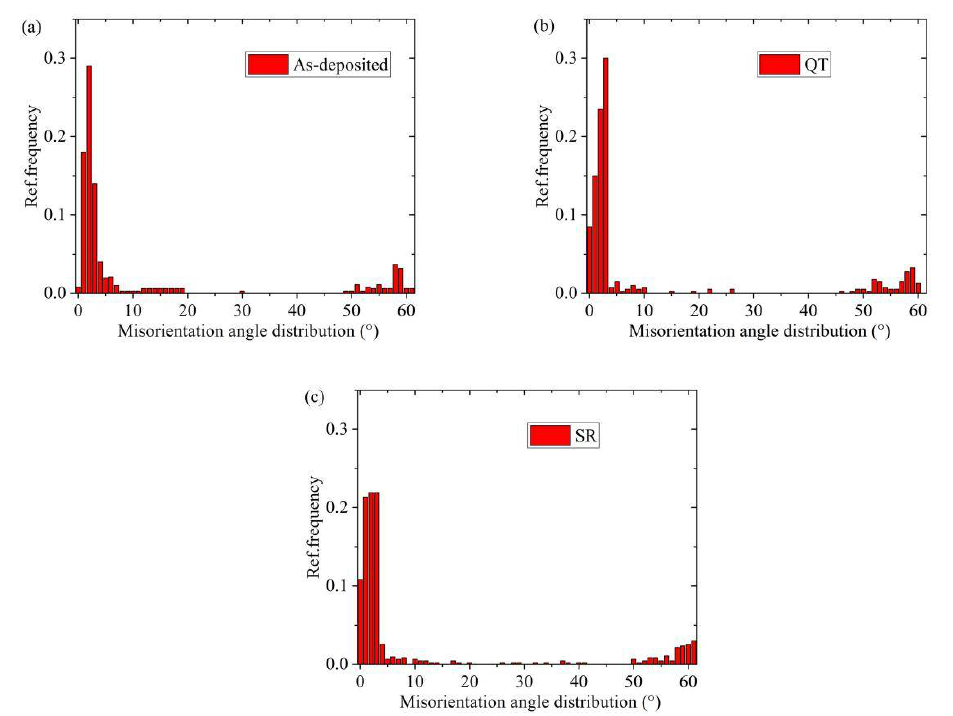
Figure 7. The misorientation angle distribution histograms of specimens: ( a ) as-deposited; ( b ) QT; ( c ) SR.